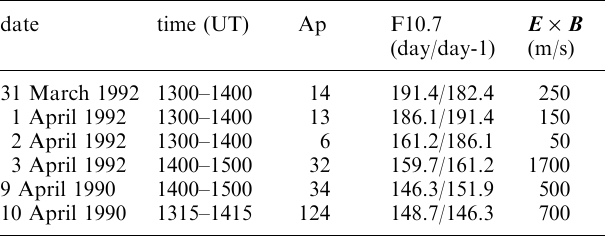
Table 1. Dates and geophysical parameters of the periods used in the study